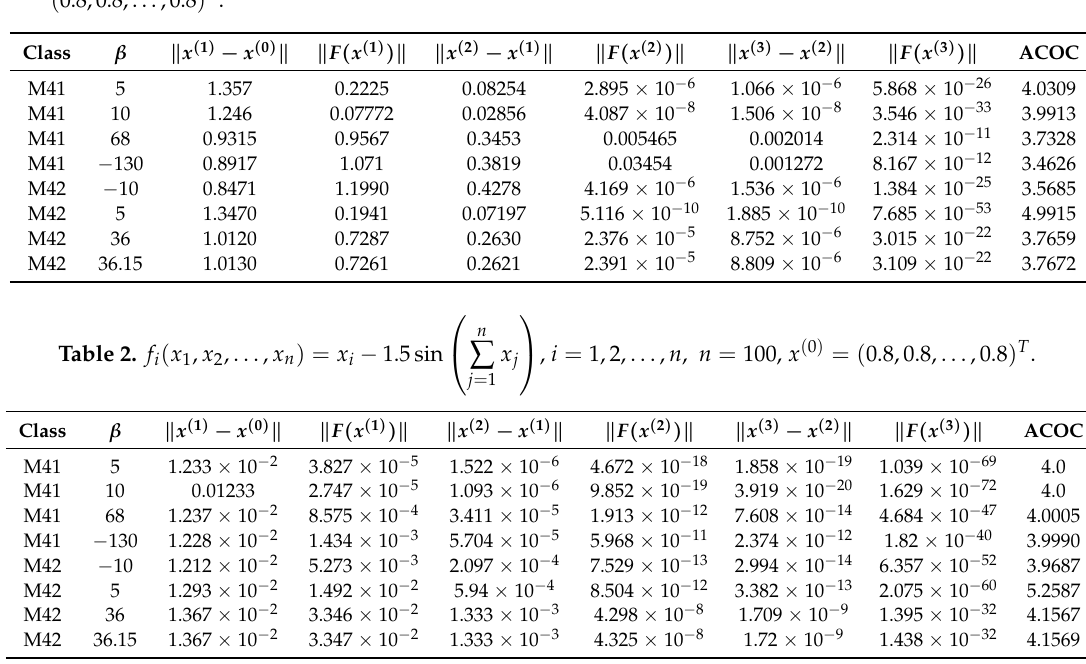
Table 1. f i ( x 1 , x 2 ,. . ., x n ) = x i − cos ( 2 x i − x 1 − x 2 − x 3 − x 4 ) , i = 1,2,. . ., n , n = 20, x ( 0 ) = ( 0.8,0.8,. . .,0.8 ) T .